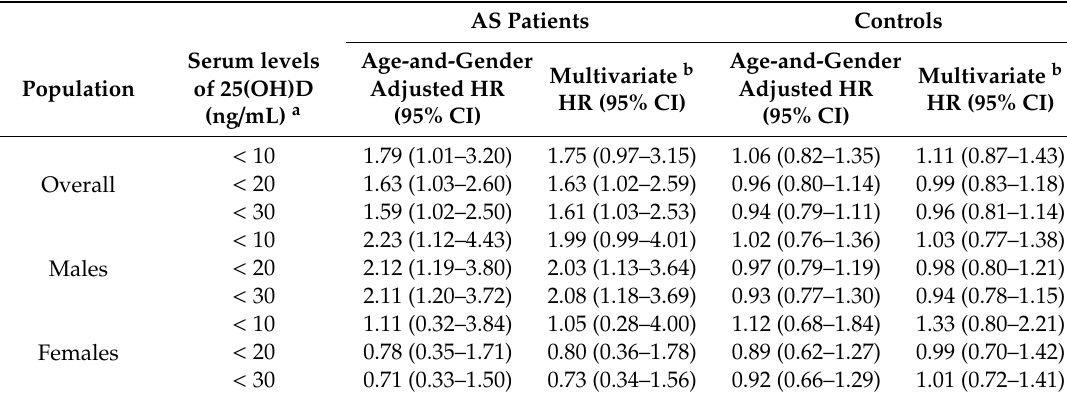
Table 3. Age- and gender-adjusted hazard ratios (HRs) for all-cause mortality for di ff erent levels of serum